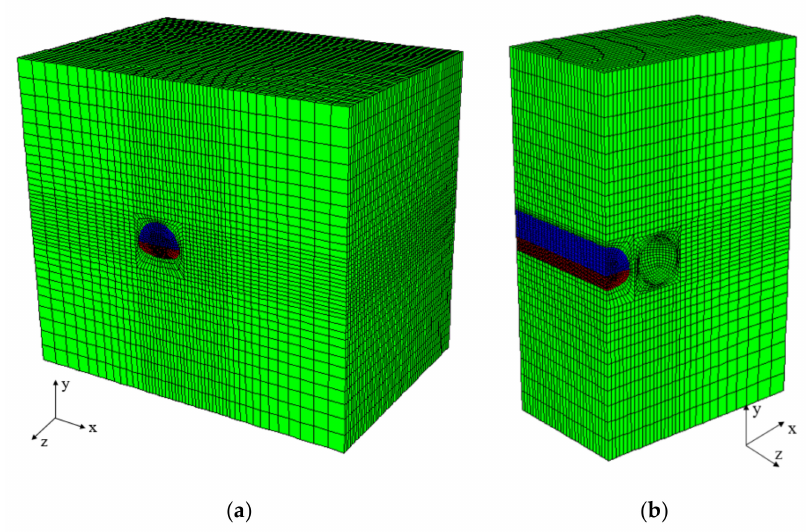
Figure 5. Model meshing: ( a ) front view, ( b ) model section.